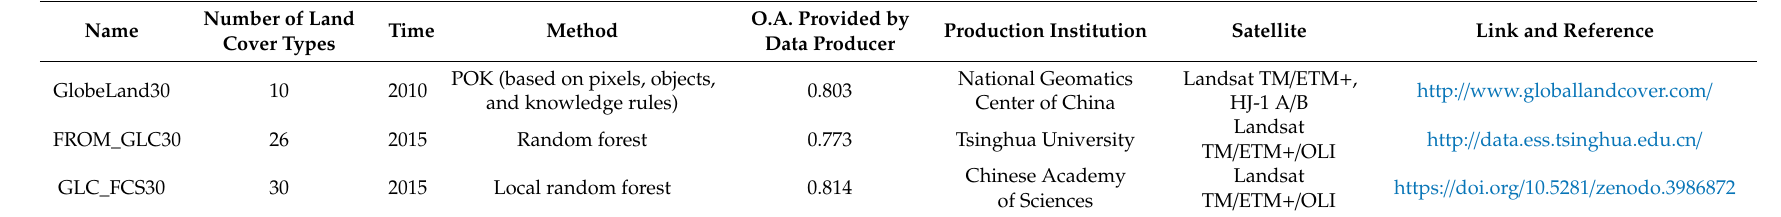
Table 1. Main characteristics of three global land-cover (GLC)